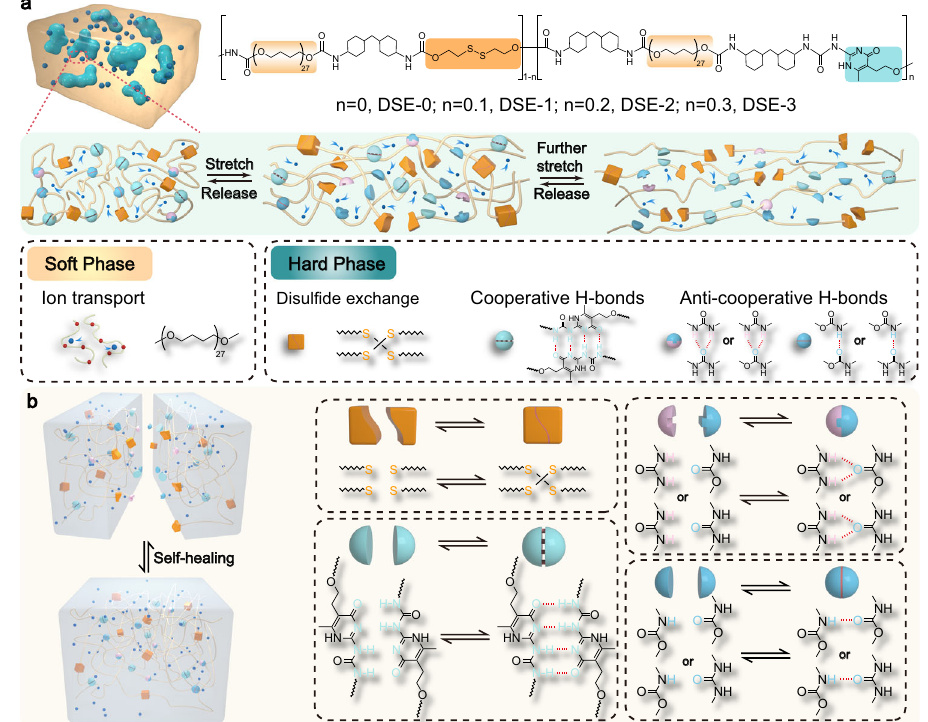
Fig. 1 | Schematic illustration of the molecular design and mechanism of dynamic supramolecular ionic conductive elastomers (DSICE) with superior stretchability and toughness, autonomous self-healing. a The chemical